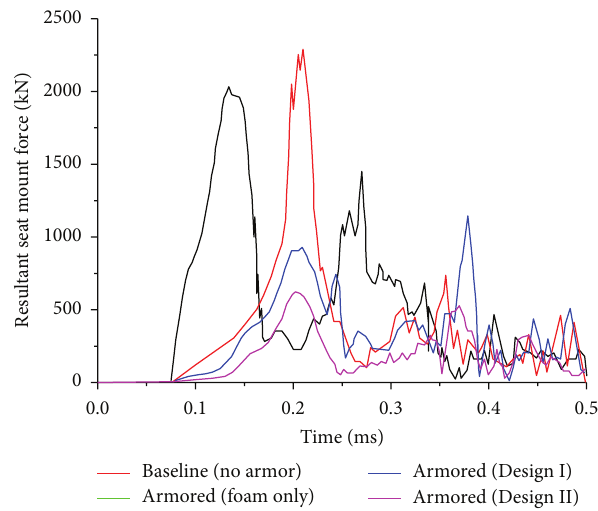
Figure 10: Comparison of seat mount forces in various designs.